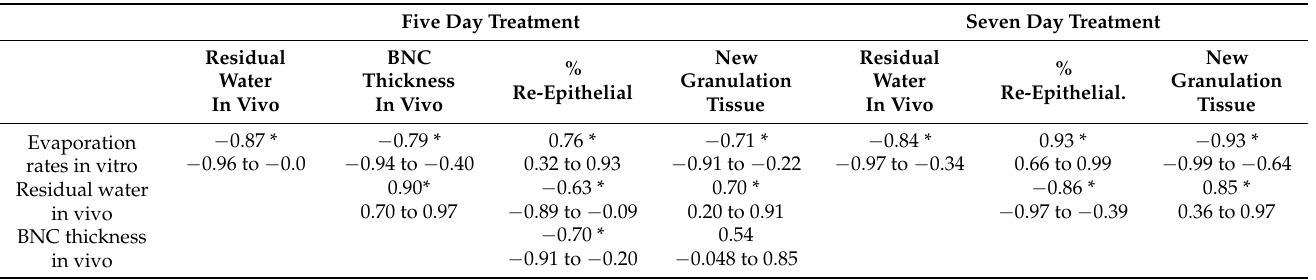
Table 2. Pearson’s correlation results for the relationship between in vitro and in vivo efficacy parameters. Results are presented as Pearson’s coefficient r at a 95% confidence interval.